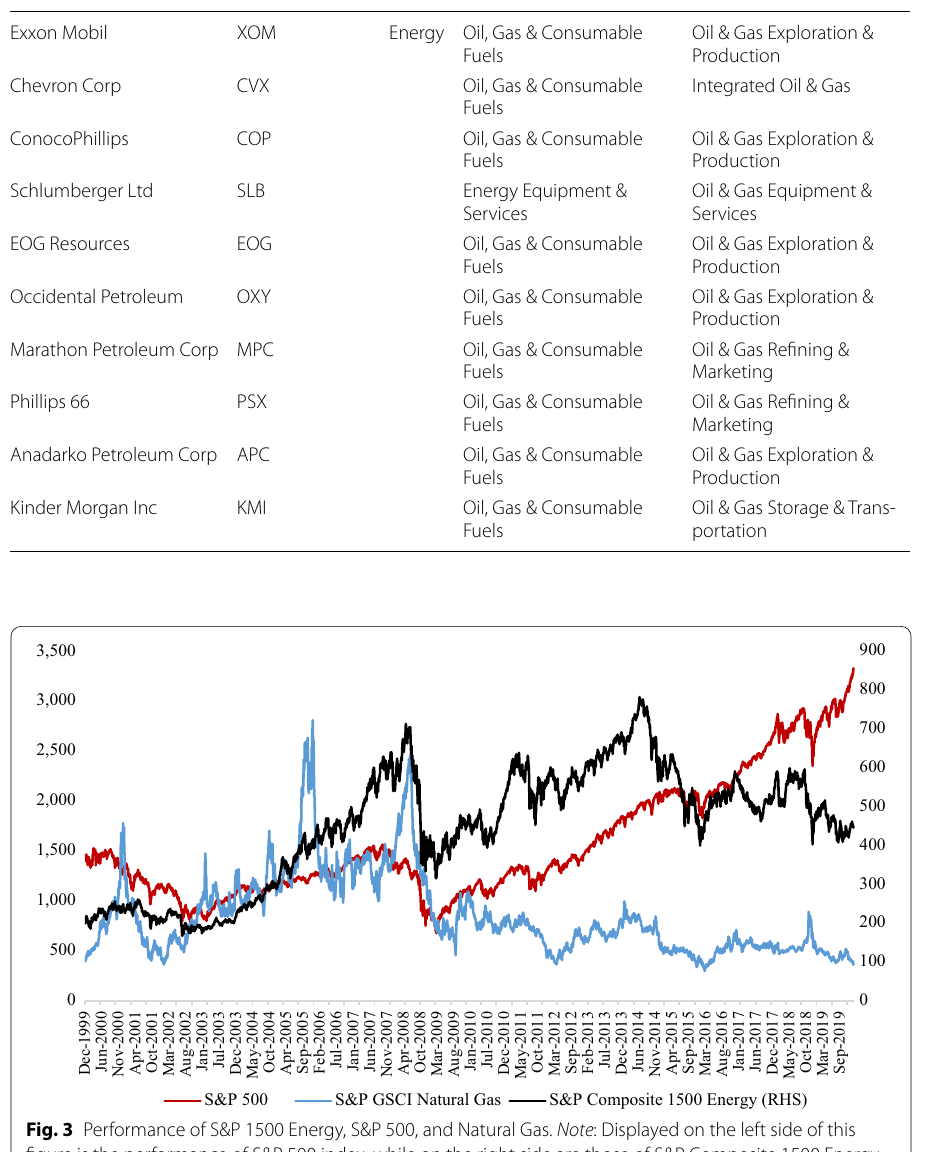
Table 1 Company specifications. Source : S&P 500 Dow Jones Indices, Factset Company